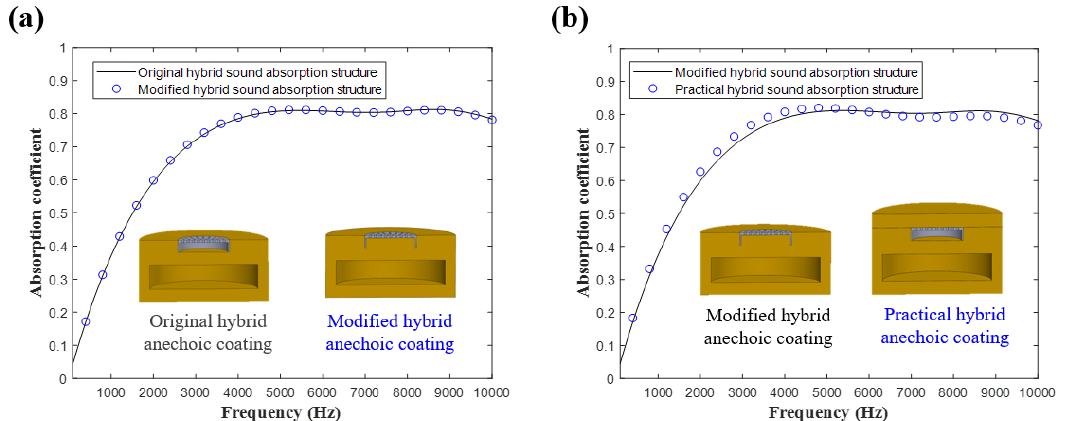
Figure 20. Sound absorption coefficients of ( a ) original and modified hybrid sound-absorbing metastructures and ( b ) modified and practical hybrid sound-absorbing metastructures.